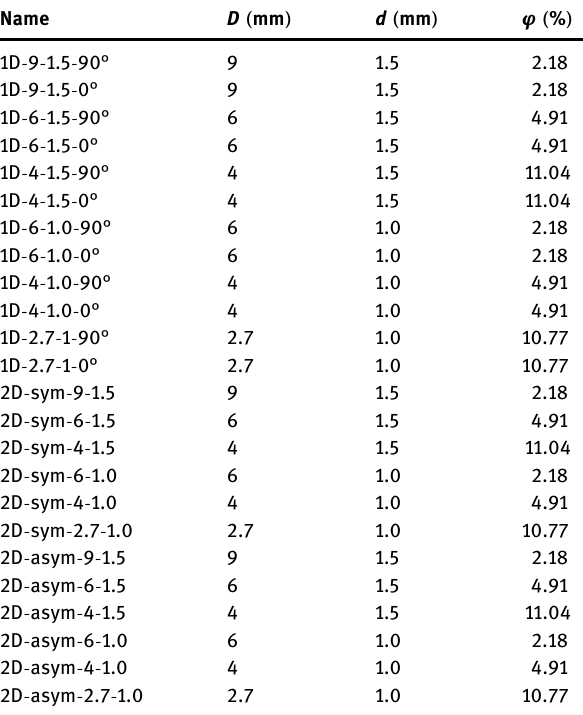
Table 1: Summary of investigated pin arrays